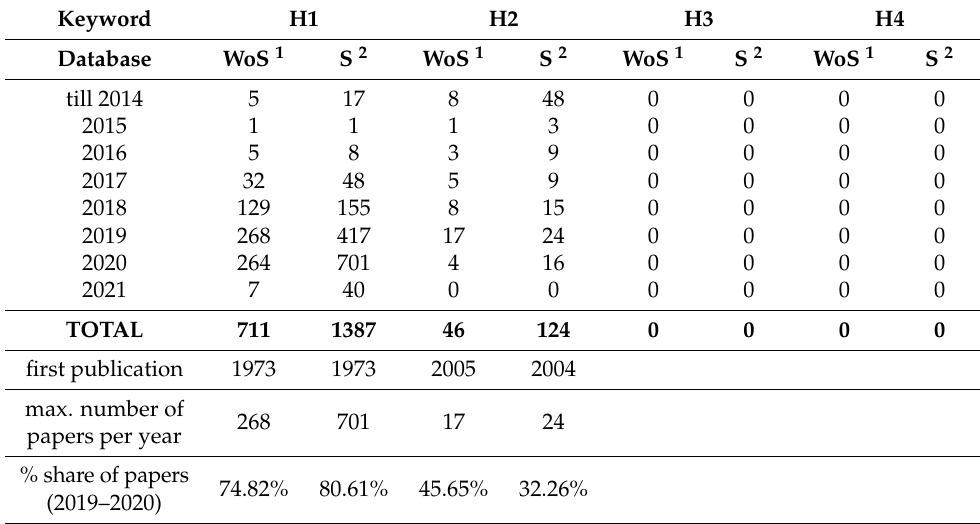
Table 3. Summary of the literature review